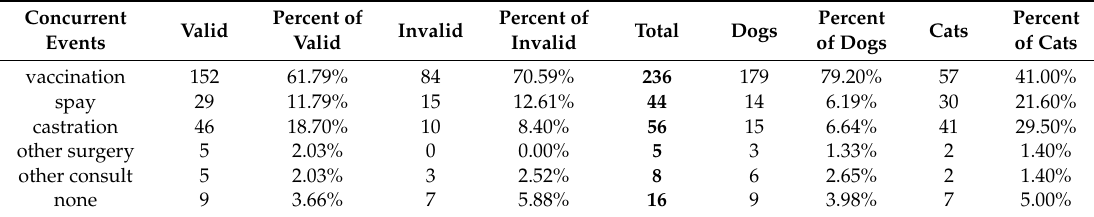
Table 4. Veterinary interactions in electronic patient records concurrent with 365 individual animal microchip implantations in 1000 randomly selected results to the search term ‘microc’ with a valid